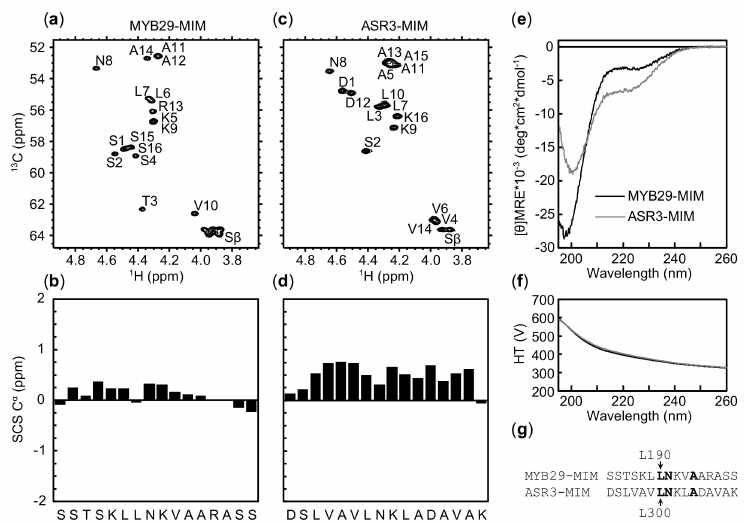
Figure 4. Structure elucidation of MYB29-MIM and ASR3-MIM. 13 C-HSQC spectra of ( a ) MYB29- MIM and ( c ) ASR3-MIM with assignments. SCS of ( b ) MYB29-MIM and ( d ) ASR3-MIM. ( e ) Far-UV CD spectra and ( f ) HT voltage of MYB29-MIM and ASR3-MIM. ( g ) Sequence alignment of MYB29- MIM and ASR3-MIM (core motif residues in